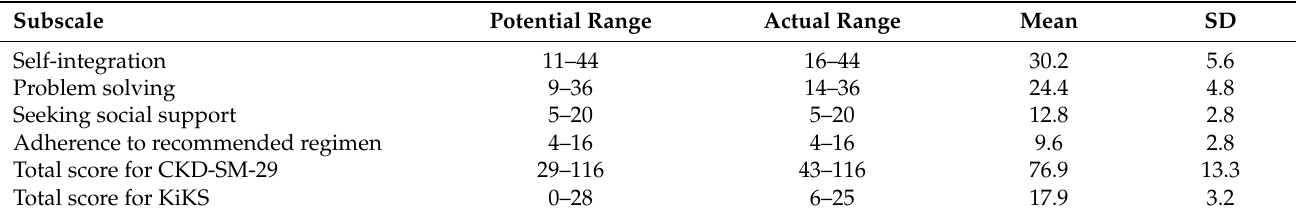
Table 2. Descriptive statistics for the CKD-SM-29 and